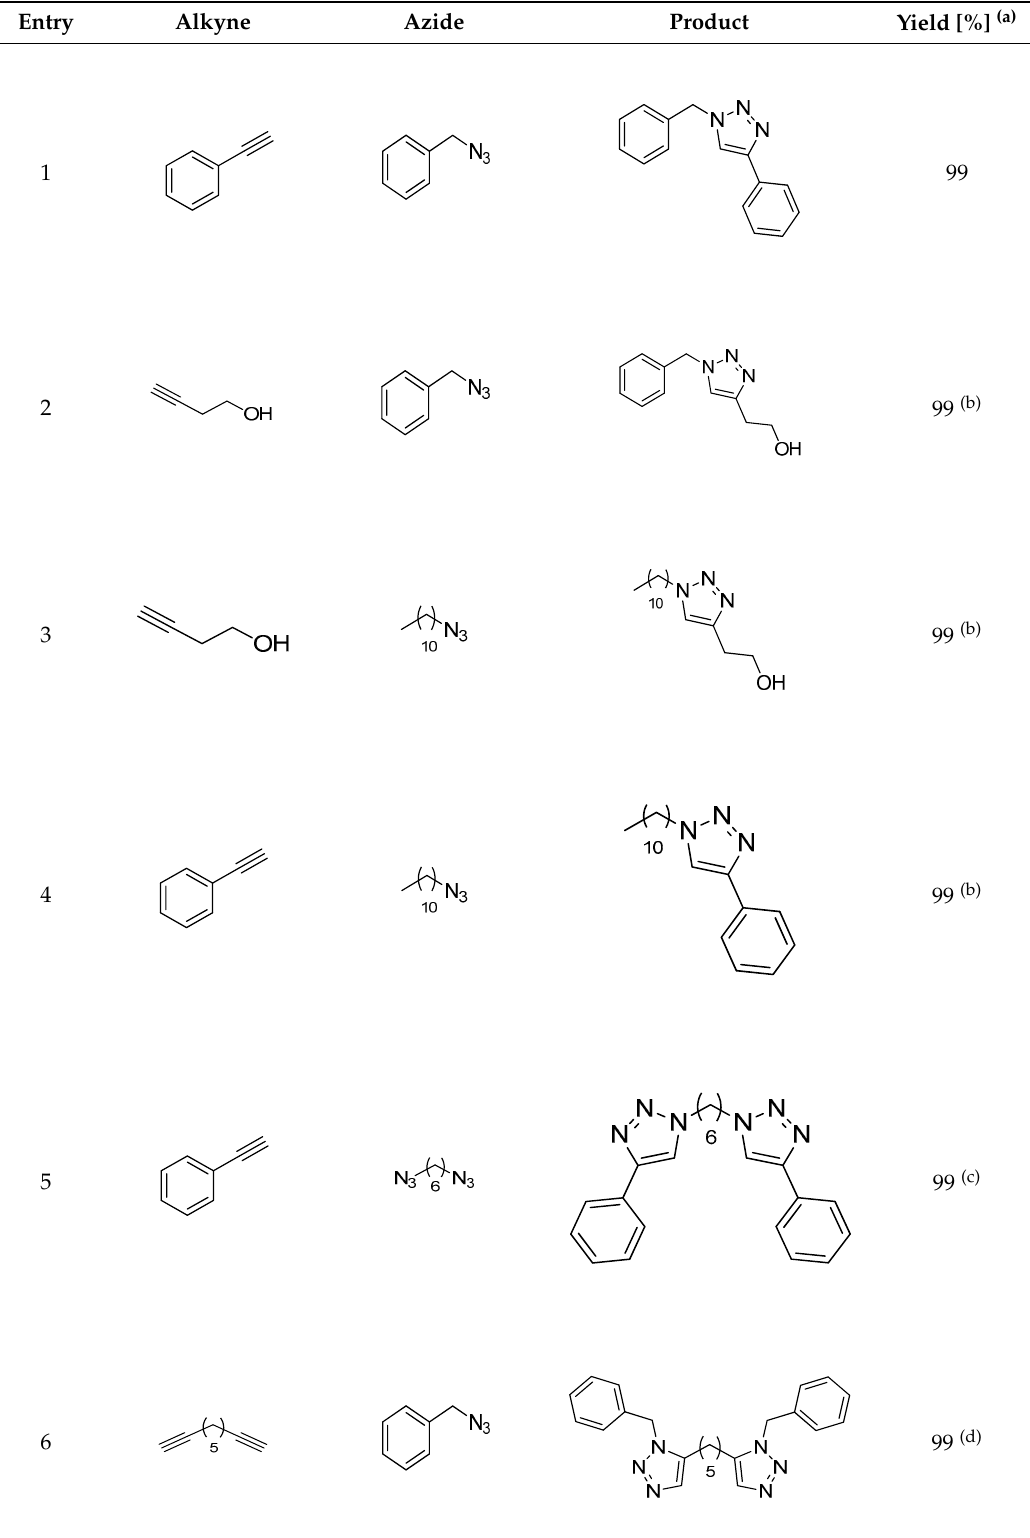
Table 3. Cu-supported catalysed CuAAC.